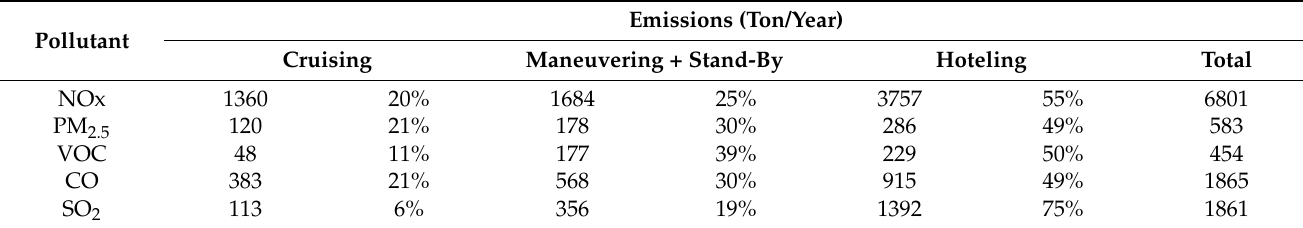
Table A12. Total emissions from vessels (Haifa, MPS A2 2025).